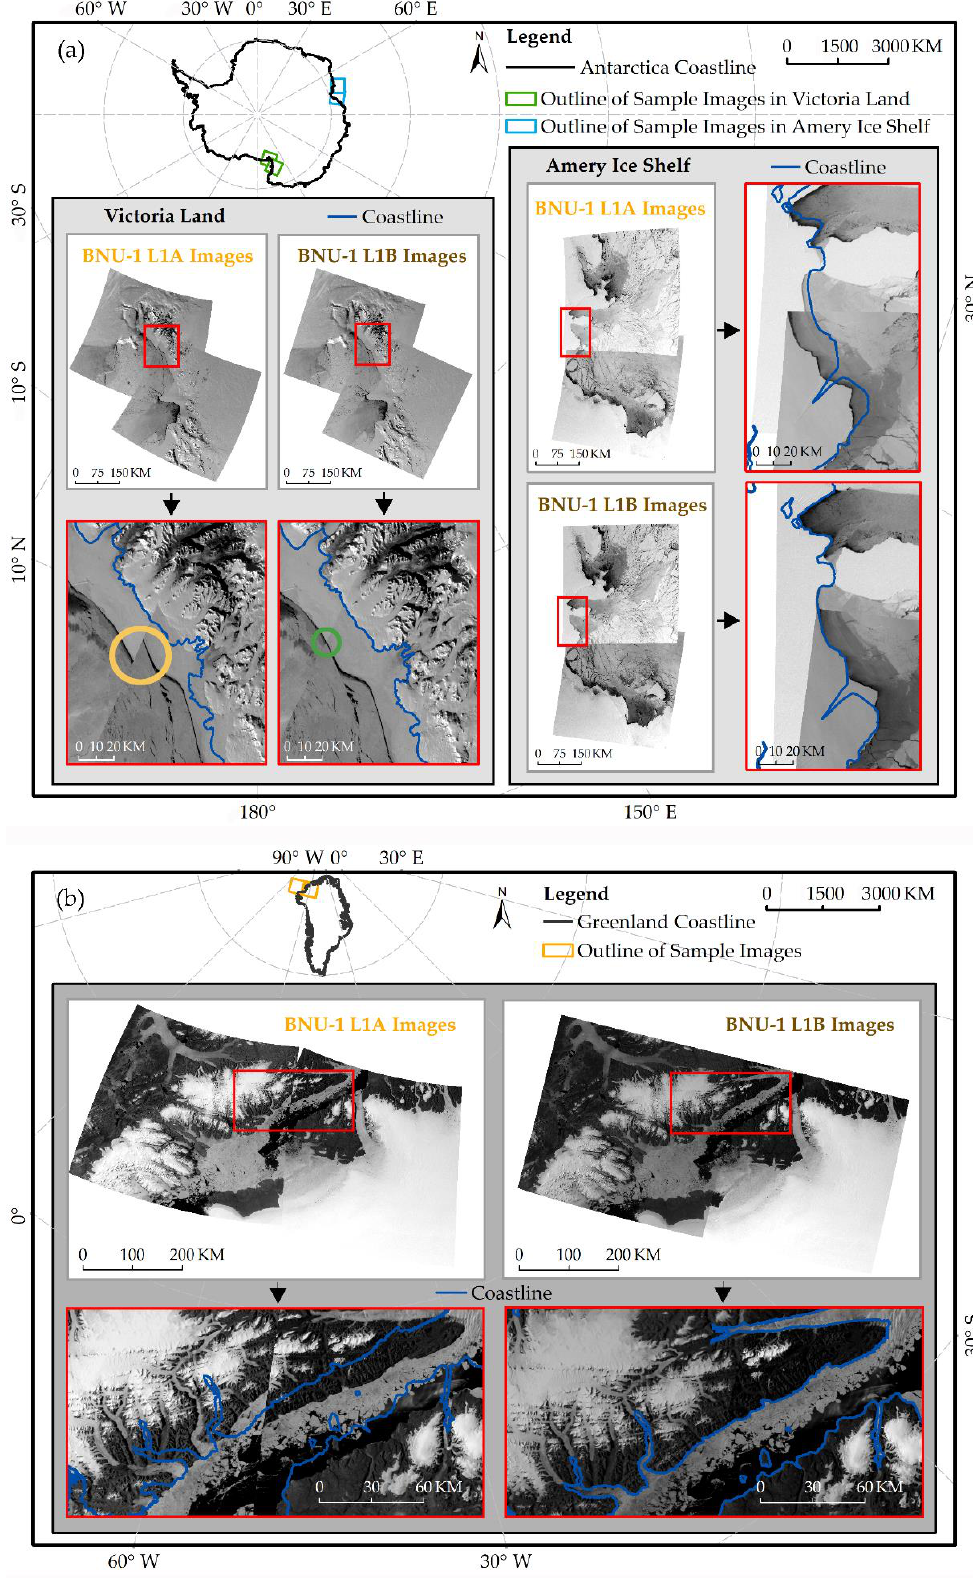
Figure 11. Mosaic of the panchromatic band images of some BNU-1 L1A/L1B Sample images: ( a ) Antarctica; ( b ) Greenland. The blue lines represent the existing coastline